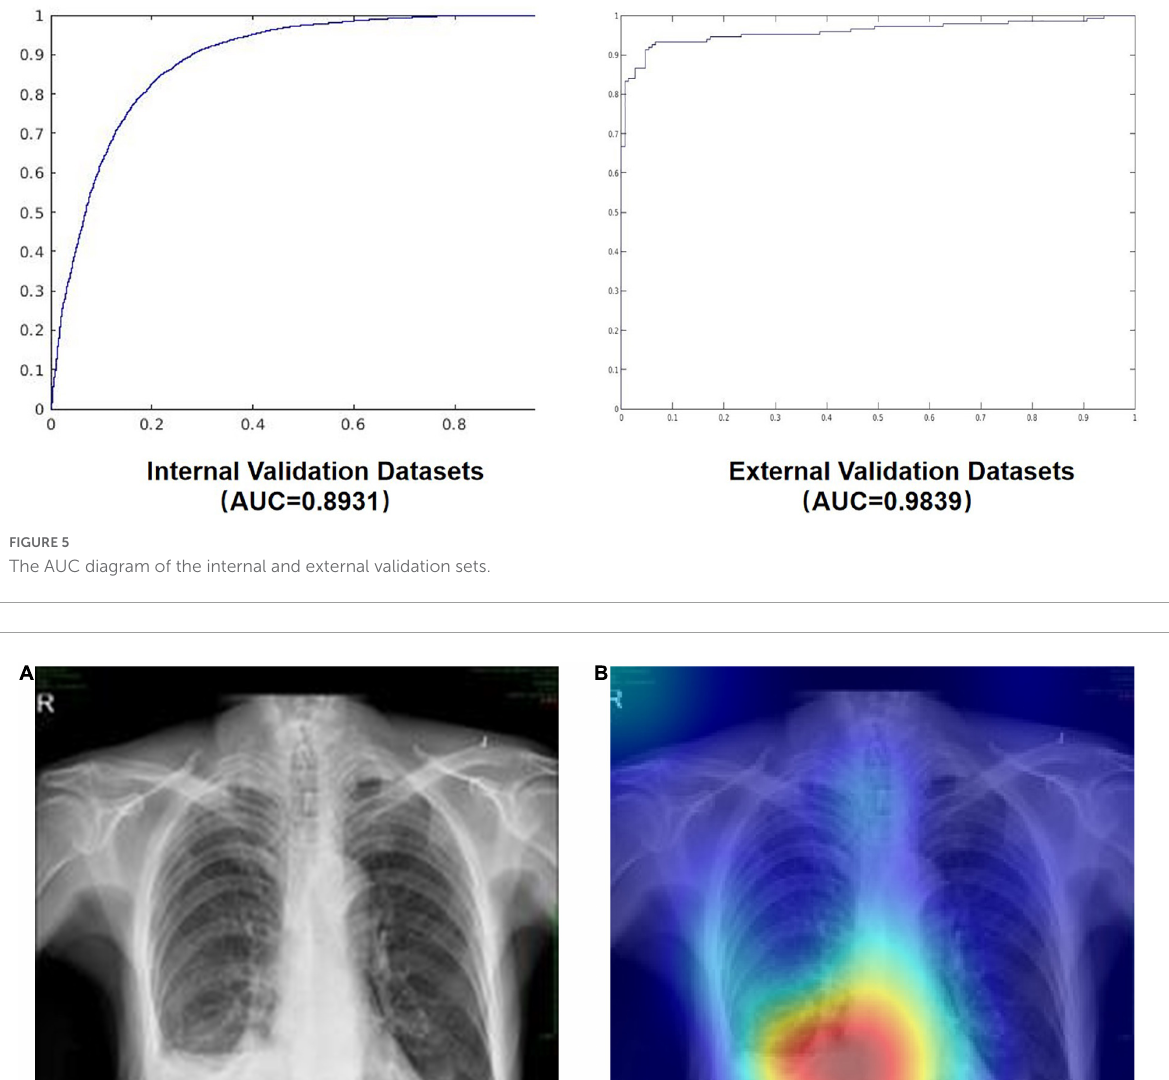
included in this paper are random and uniform data,